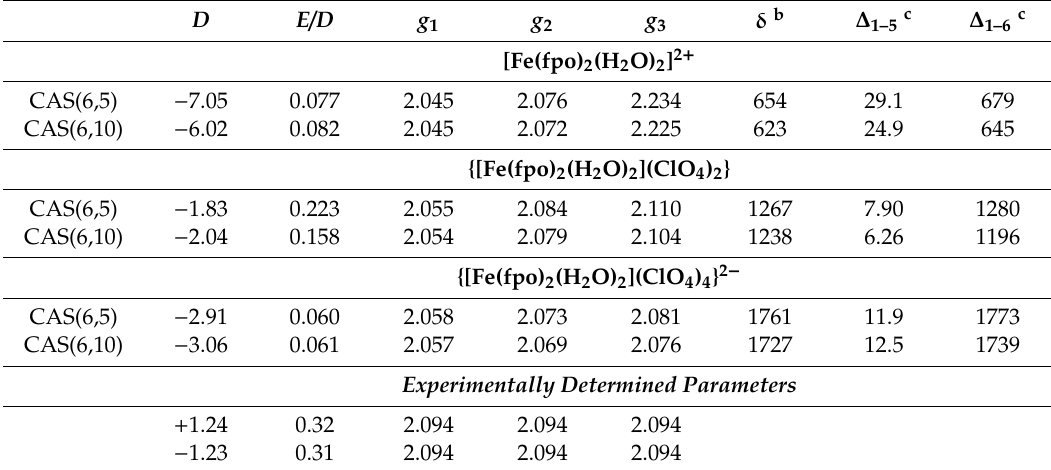
Table 2. Comparison of the spin Hamiltonian parameters for 1 derived from CASSCF / NEVPT2 calculations done in ORCA and the experimental magnetic data a .